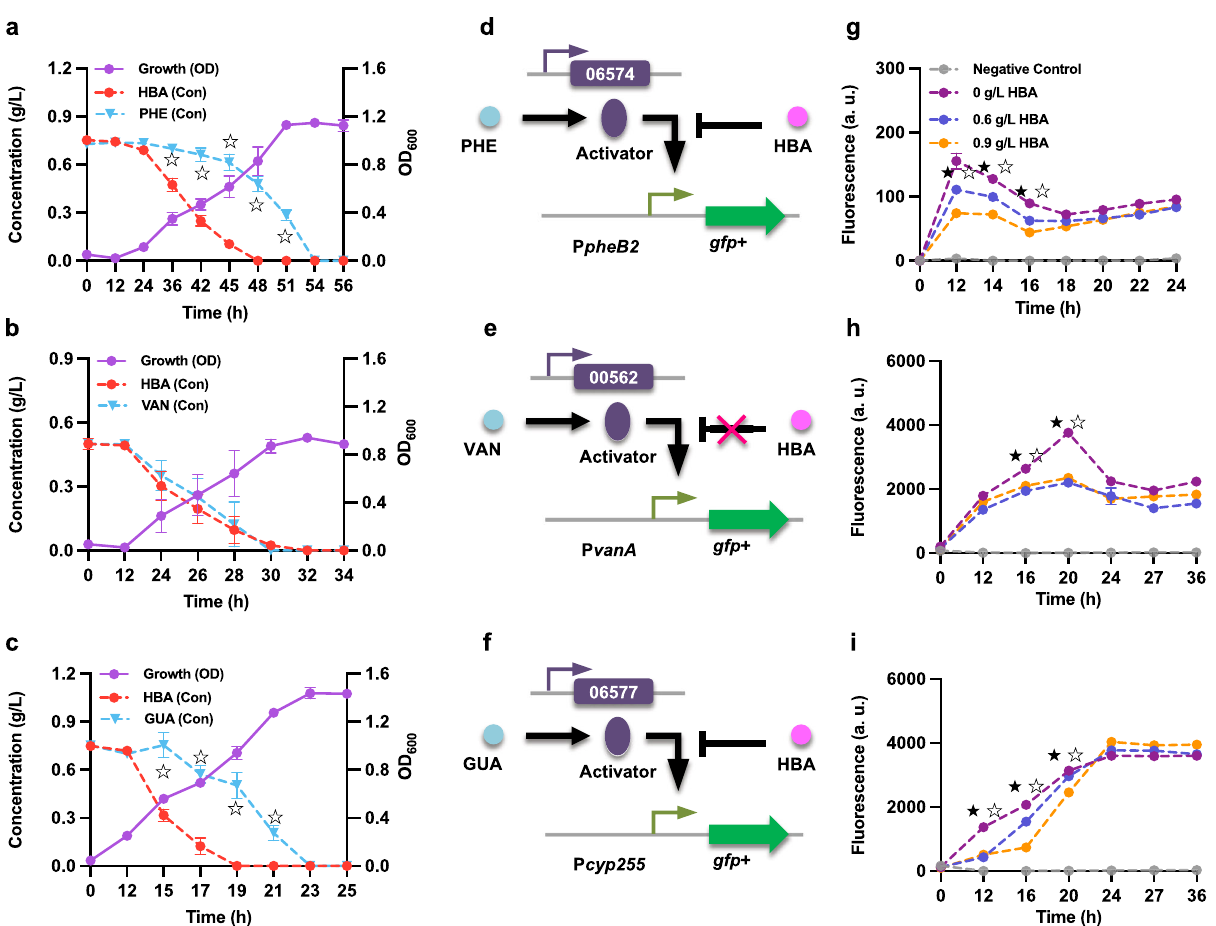
Fig. 7 Preferential utilization of 4-hydroxybenzoate (HBA) over phenol (PHE) and guaiacol (GUA) by R. opacus . a – c Utilization pro fi les of the aromatic mixtures. A glucose-grown WT cell culture was used as the inoculum. Cells were cultured in minimal medium with different aromatic mixtures as carbon sources: a 0.75 g/L HBA + 0.75 g/L PHE; b 0.5 g/L HBA + 0.5 g/L VAN; c 0.75 g/L HBA + 0.75 g/L GUA. At each time point, a 200 μ L cell